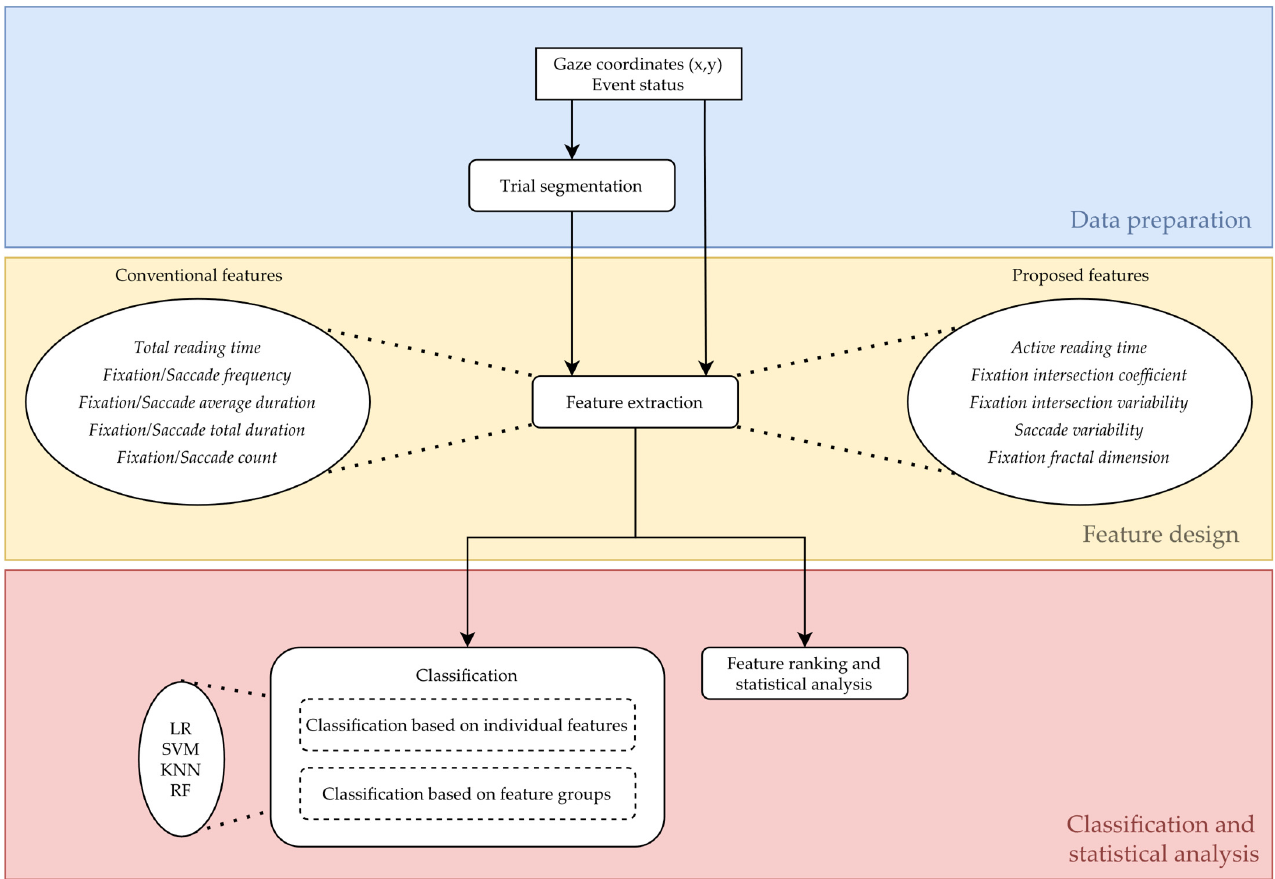
Figure 2. The analysis pipeline. LR—logistic regression; SVM—support vector machine; KNN—k- nearest neighbors; RF—random forest.